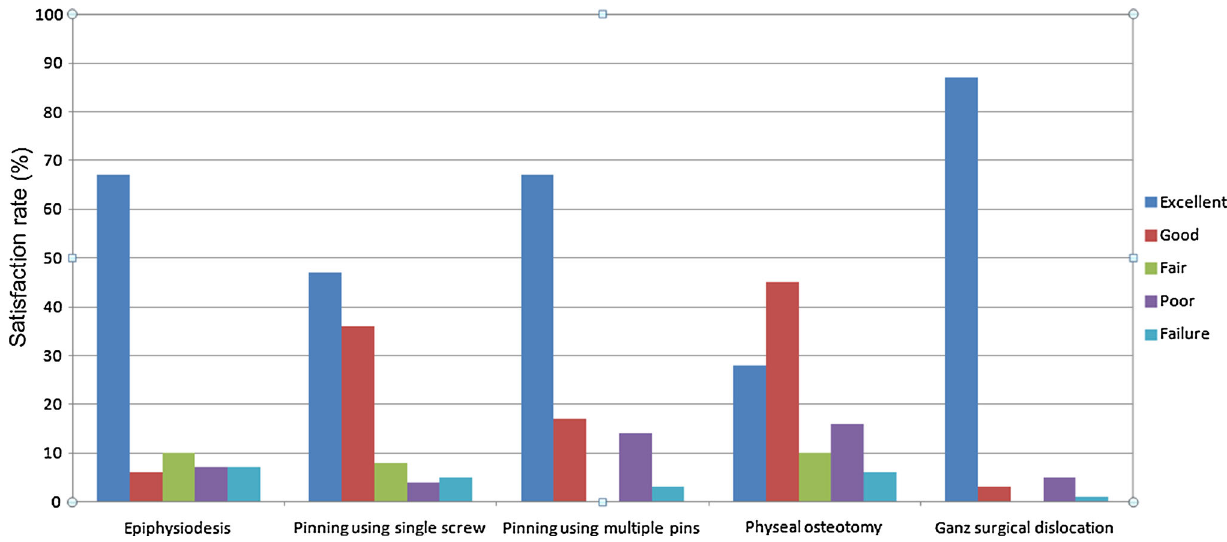
Fig. 2 Satisfaction rates among various interventions to treat slipped capital femoral